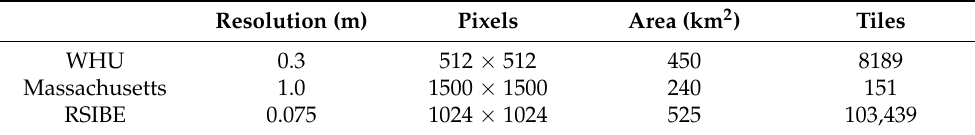
Table 2. Details of each